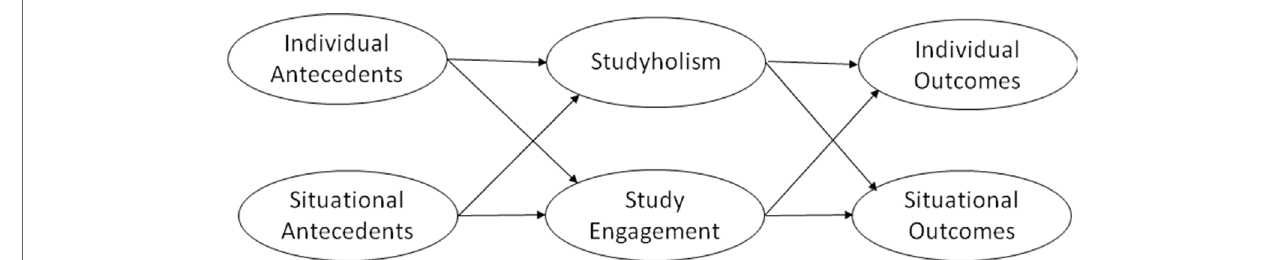
FIGURE 1 | Loscalzo and Giannini’s (2017b) theoretical model.